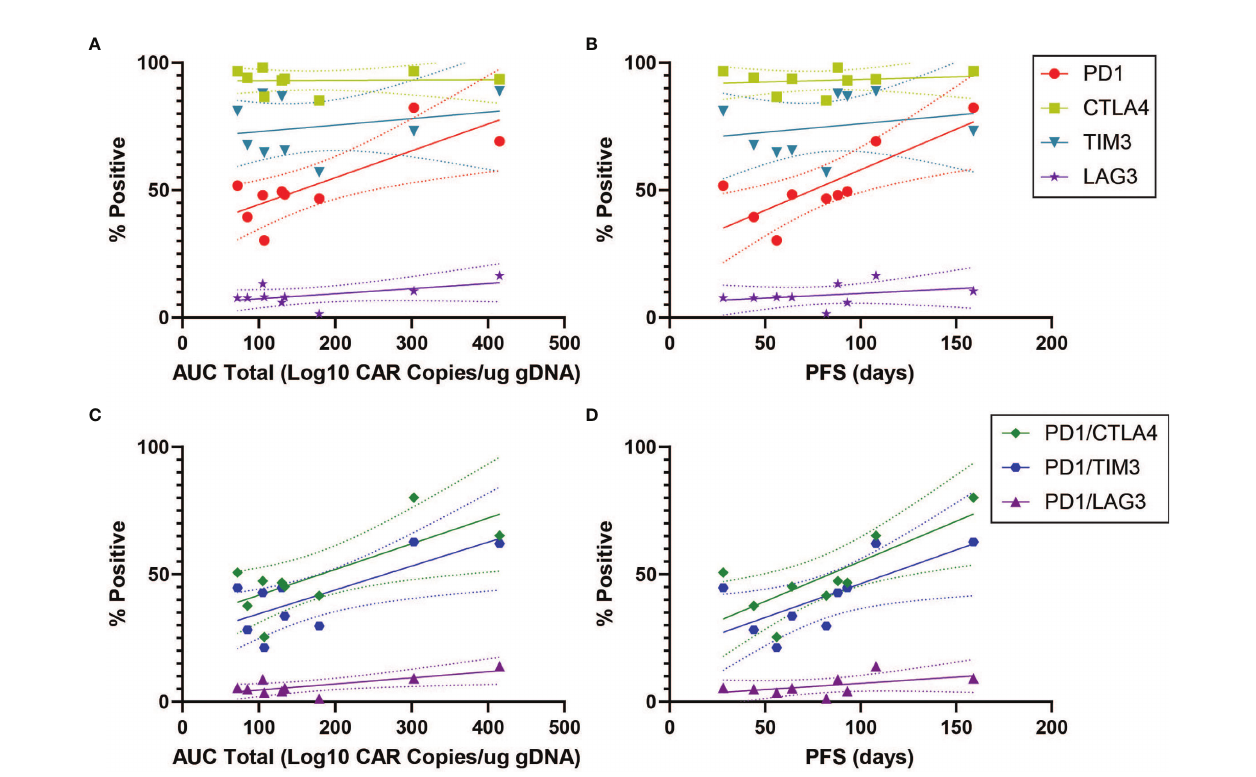
FIGURE 3 | ICI Correlations for CD4 + CAR + Cells in Patient Transduction Products. Correlation of ICI expression (CTLA4, TIM3, LAG3) with clinical outcomes for CD4 + CAR + cells in patient transduction products. (A) Association between ICI expression and total AUC. (B) Association between ICI expression and PFS. (C) Correlation of PD1-ICI co-expression (PD1 + CTLA4 + , PD1 + TIM3 + , and PD1 + LAG3 + ) and AUC. (D) Correlation of PD1-ICI co-expression and PFS. Error bars shown are 95% con fi dence